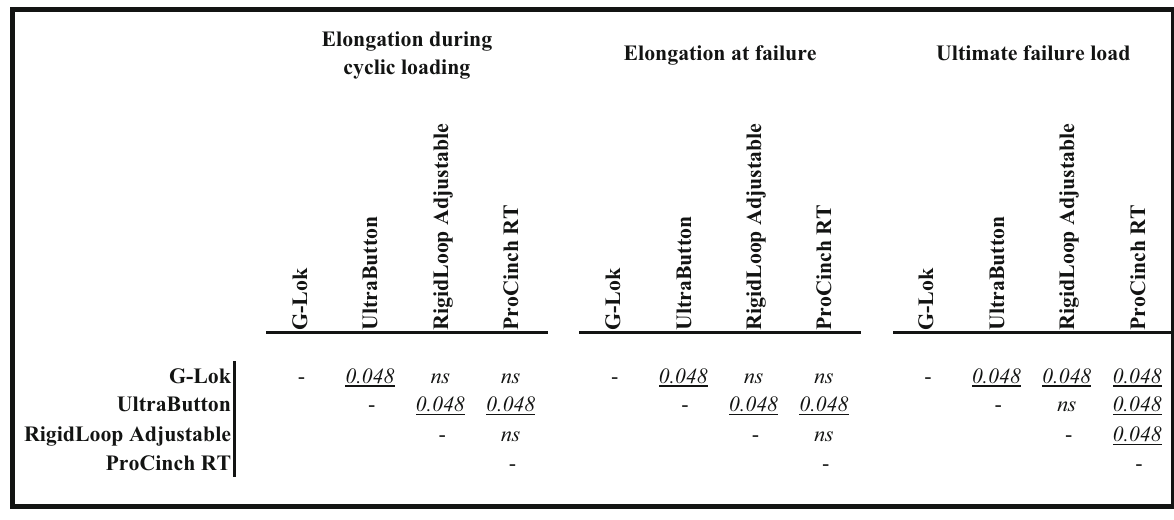
Table 2 Comparison across cortical suspension devices for elongation and load data